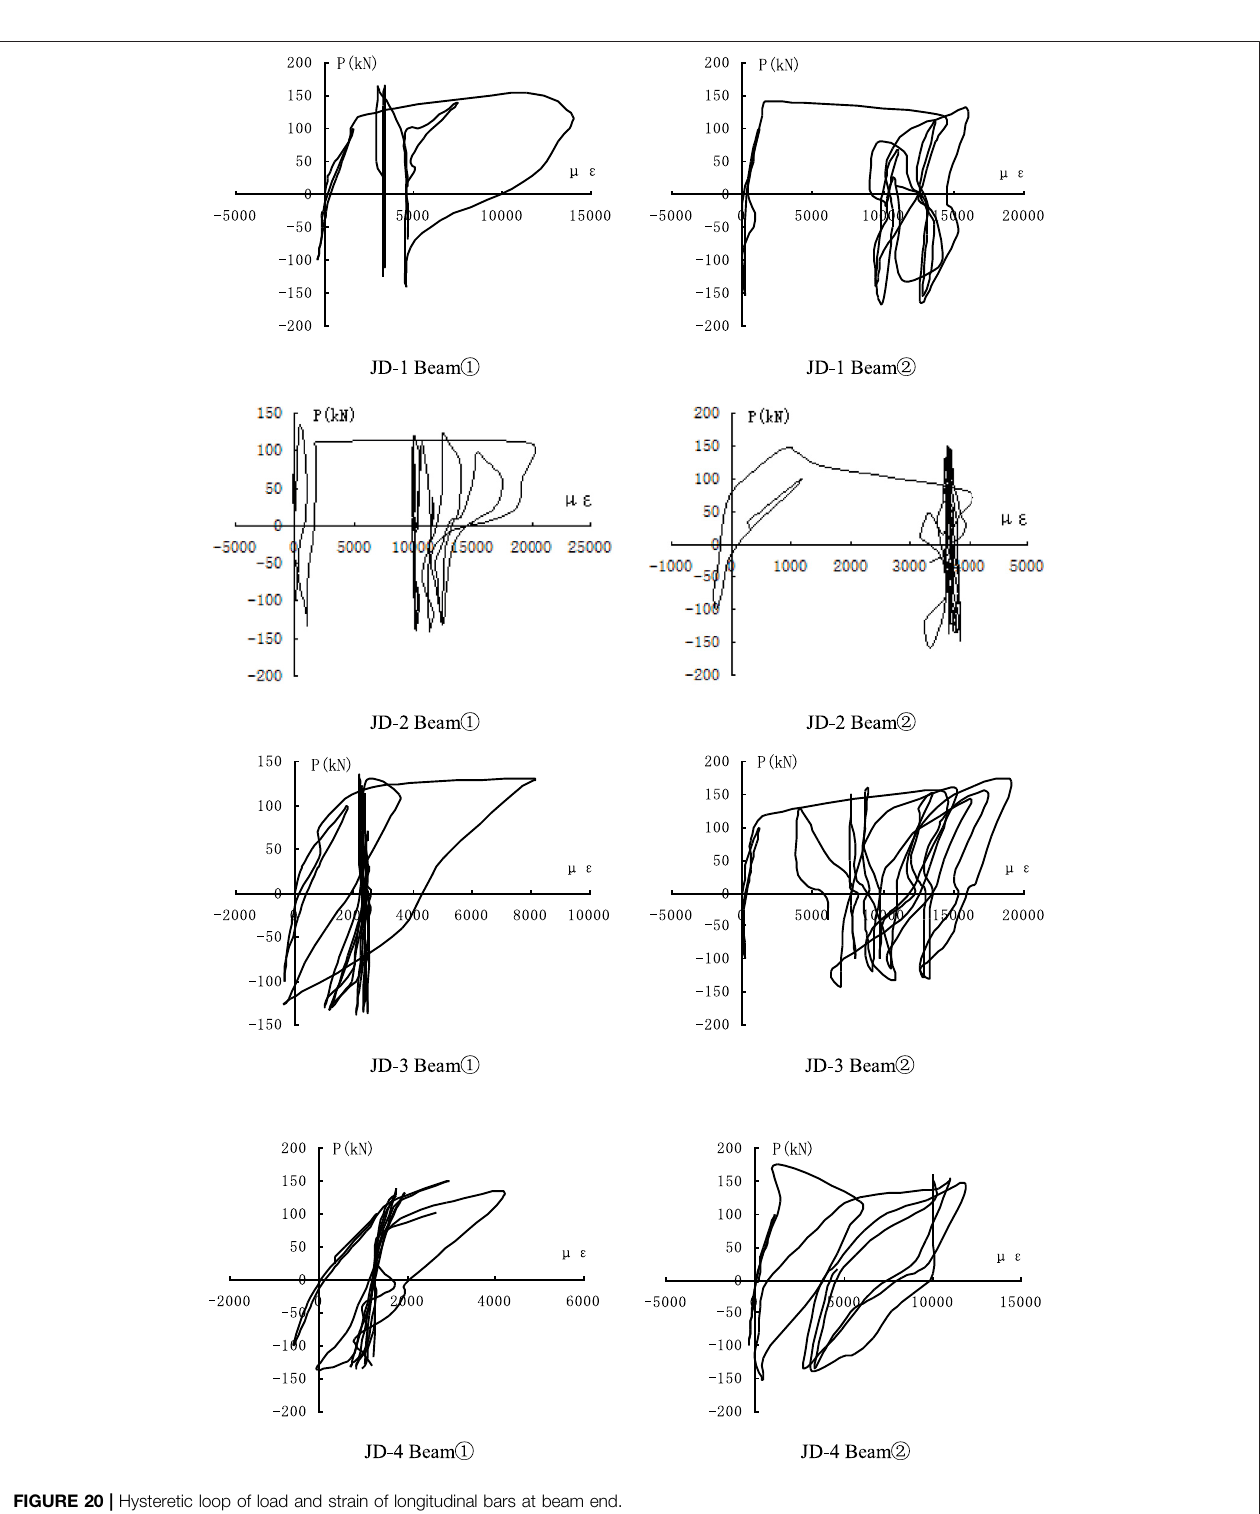
FIGURE 20 | Hysteretic loop of load and strain of longitudinal bars at beam end.